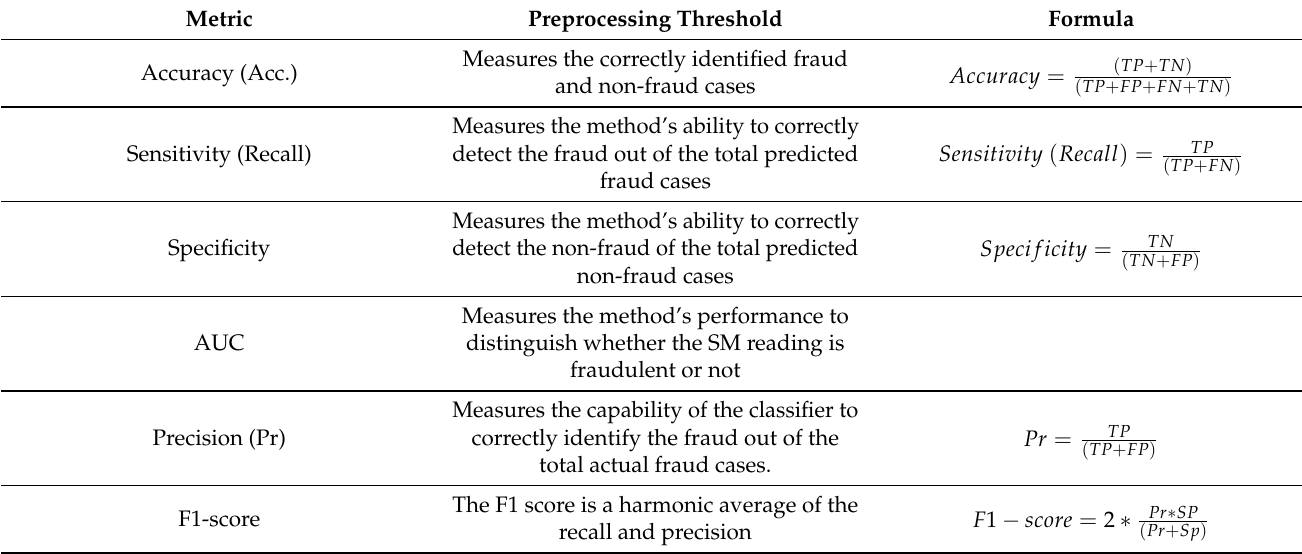
Table 4. Performance metrics used in this work to Compare the